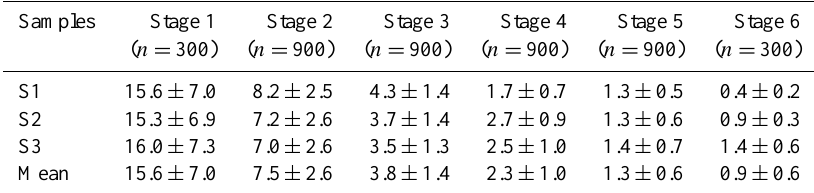
Table 2. Mean equivalent diameters (µm) of the particles analyzed at different